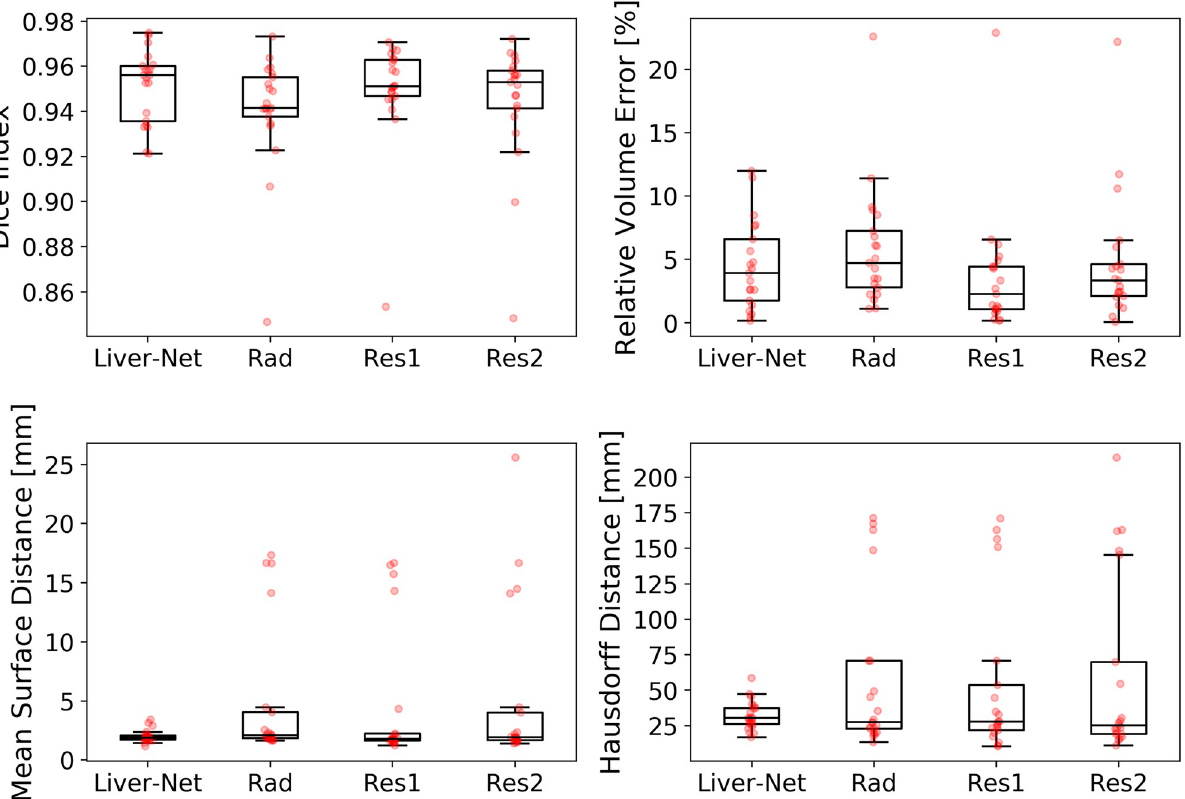
Fig 3. Box plots showing segmentation quality of Liver-Net and that of manual routine segmentations.